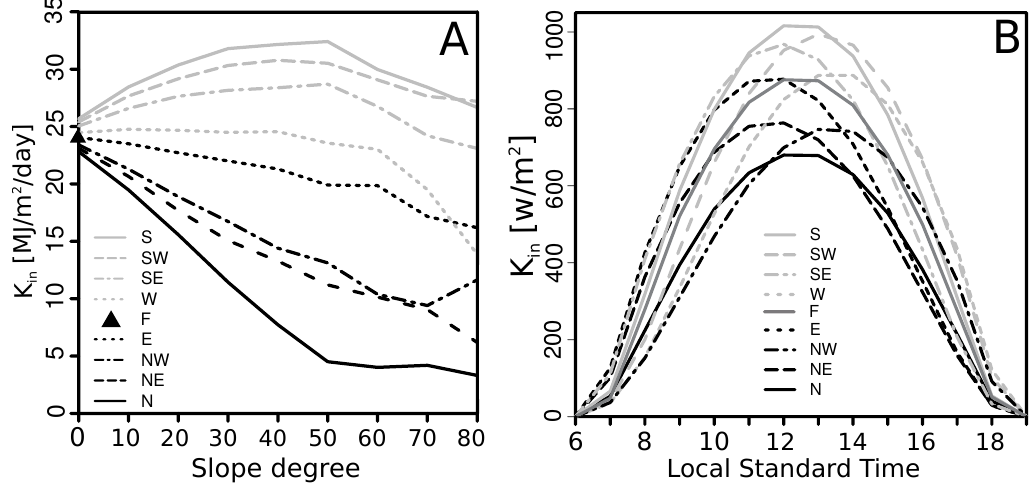
Figure 8. ( A ) Cumulative diurnal incident solar radiation ( K in ) in MJ/m 2 /day for different slope degrees and aspects and ( B ) hourly instantaneous incident radiation flux ( K in ) in w/m 2 for different slope aspects including flat TIN elements (F), during 20 March (i.e., spring equinox) of year